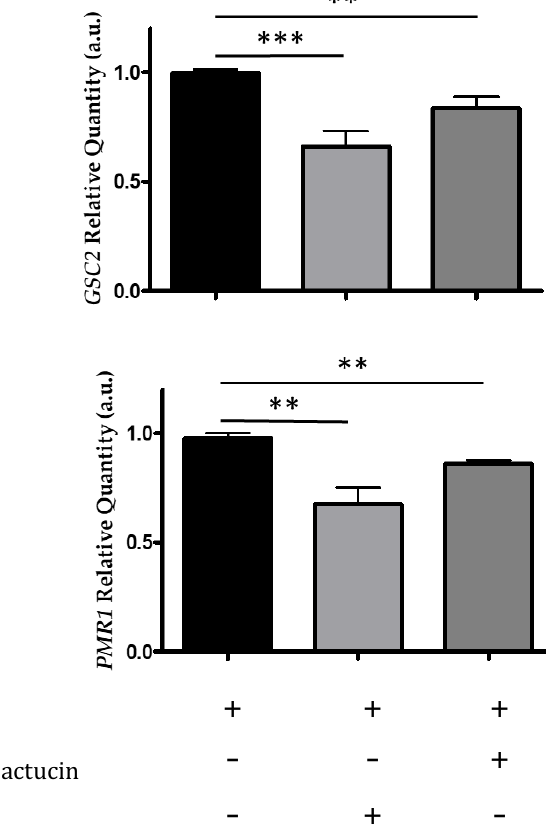
Figure 7. 11 β ,13-dihydrolactucin modulates the downregulation of endogenous Crz1 target genes. BY4741 cells were subjected to 3.6 µ M of 11 β ,13-dihydrolactucin, induced with 3 mM MnCl 2 and the mRNA levels of Crz1 target genes PMR1 and GSC2 were assessed by qPCR. The immunosuppressant FK506, which inhibits calcineurin and prevents Crz1 activation, was used as a positive control. The values represent the mean ± SEM of at least three biological replicates, ** p < 0.01, *** p <